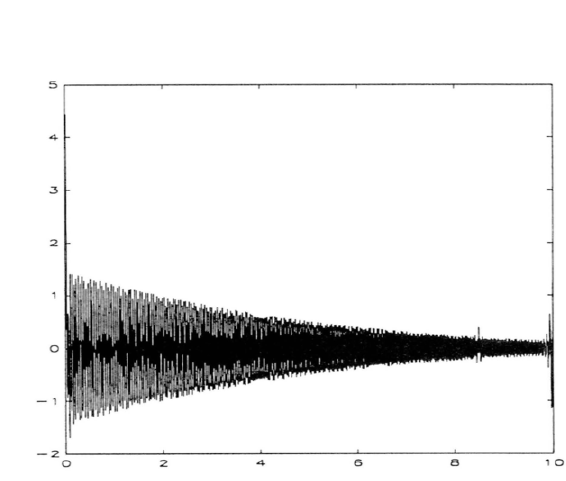
FIGURE 7 Percent tracking error with data bias (r(n) = 11 10).